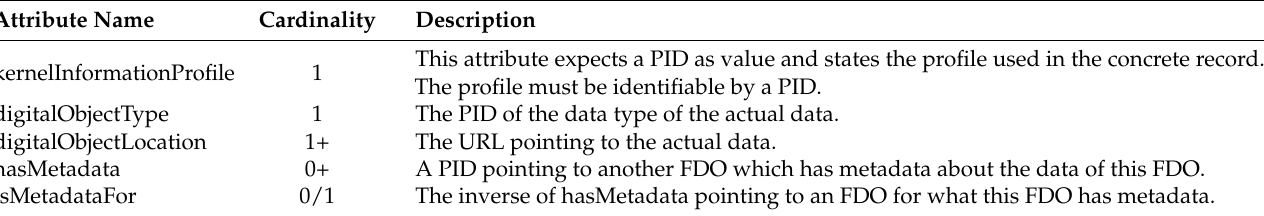
Table 1. Helmholtz Kernel Information